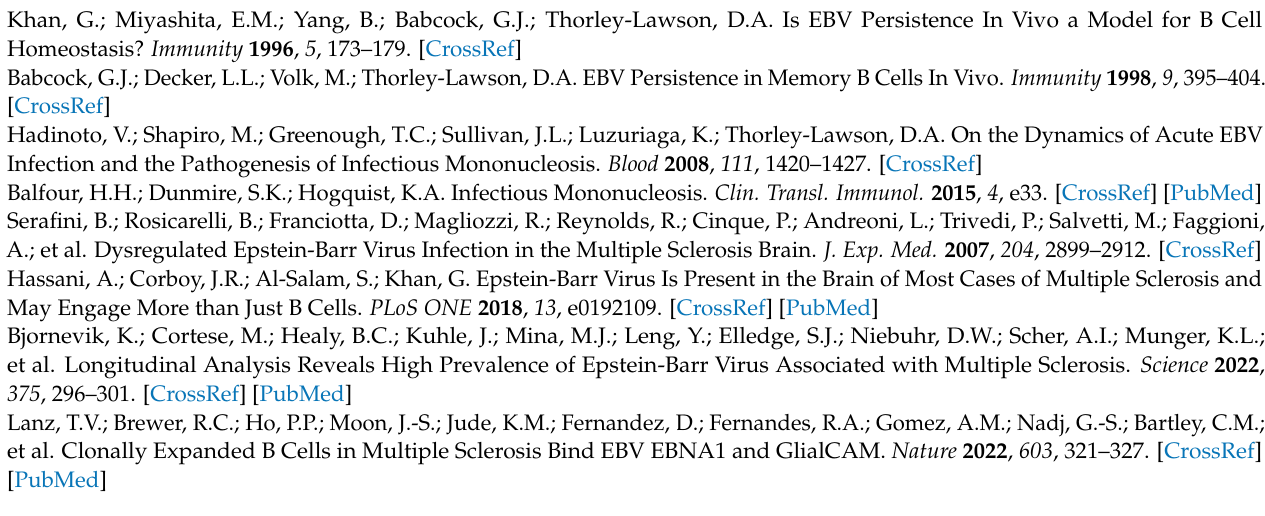
amplify genomic DNA from rabbit tissues. Table S2: List of primers for rabbit cellular transcripts and EBV genes. Figure S1: Detection of EBV lytic gene BZLF1 in rabbit